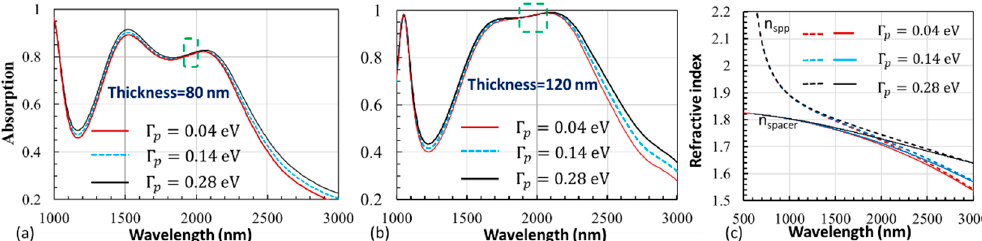
Figure 5. Simulated absorption in a stack of Au-GPSC/weakly-absorbing-spacer/Au-film with a spacer thickness of ( a ) 80 nm and ( b ) 120 nm for carrier relaxation rates of 0.04, 0.14 and 0.28 eV in Equation (5) for an AZO spacer. ( c ) Dispersion of the refractive index n spp and n AZO with carrier relaxation rates of 0.04, 0.14 and 0.28 eV in Equation (5) for an AZO spacer.